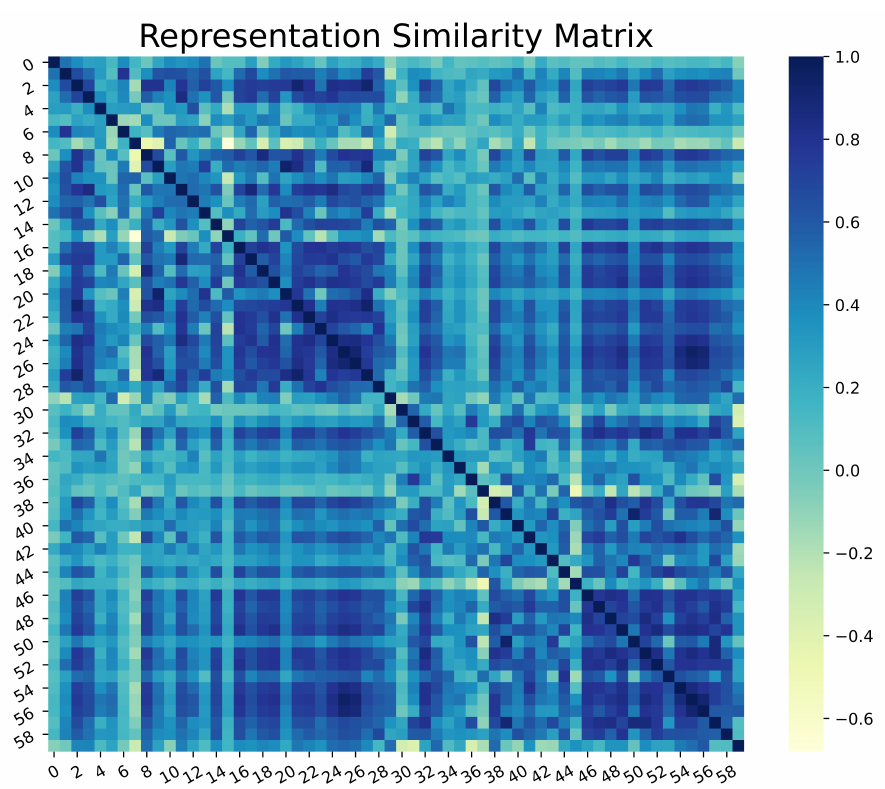
Figure 12. Representation Similarity Matrix of Real and Generated Skin